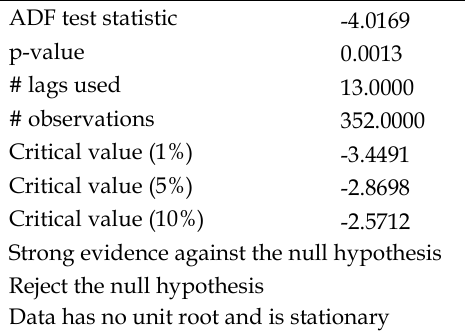
ADF Test results on differenced time-series